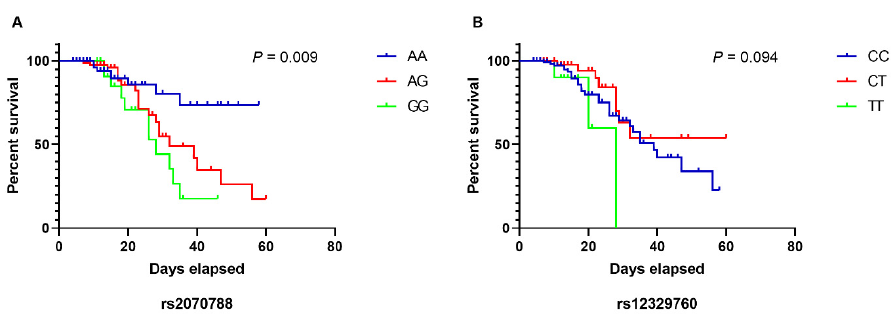
Figure 1. Influence of the transmembrane serine protease type 2 (TMPRSS2) polymorphisms on the risk of death in older individuals hospitalized with COVID-19 according to Kaplan–Meier method. ( A ) rs2070788, mean time (days) GG: 28.7, AG: 36.9, AA: 48.6, log-rank = 0.009. ( B ) rs12329760, mean time (days) TT: 23.8, CT: 44.4, TT: 38.3, log-rank = 0.094.